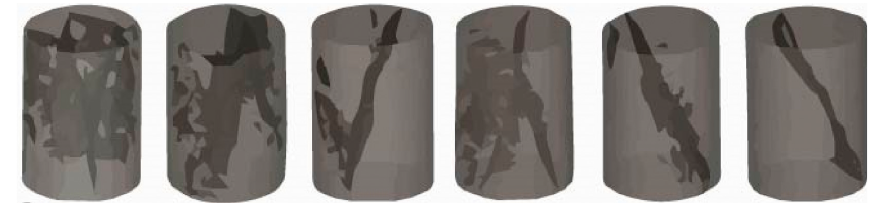
Figure 5: 3D geometric models of failure cracks, from Yang et al.